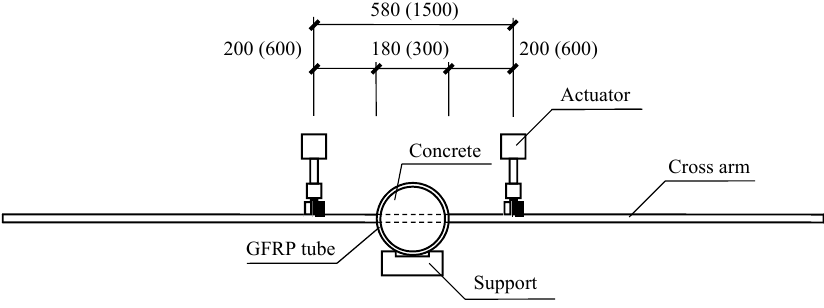
Figure 3. Test set-up (unit in mm, not to scale).